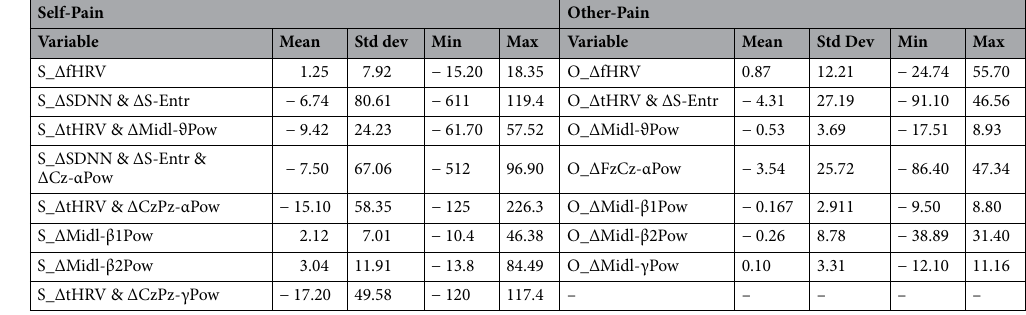
Table 2. Descriptive statistics for PCA factor difference scores (Control minus Placebo, ∆) including ∆Frequency HRV (∆fHRV), ∆Standard Deviation of R–R time intervals (∆SDNN), ∆Sampling Entropy (∆S-Entr), frequency bands of ϑ, α, β1, β2, and γ (∆Midl-ϑPow, ∆Cz-αPow, ∆CzPz-αPow, ∆Midl-β1Pow, ∆Midl-β2Pow, and ∆CzPz-γPow), respectively for Self-Pain (S) and Other-Pain (O) conditions.